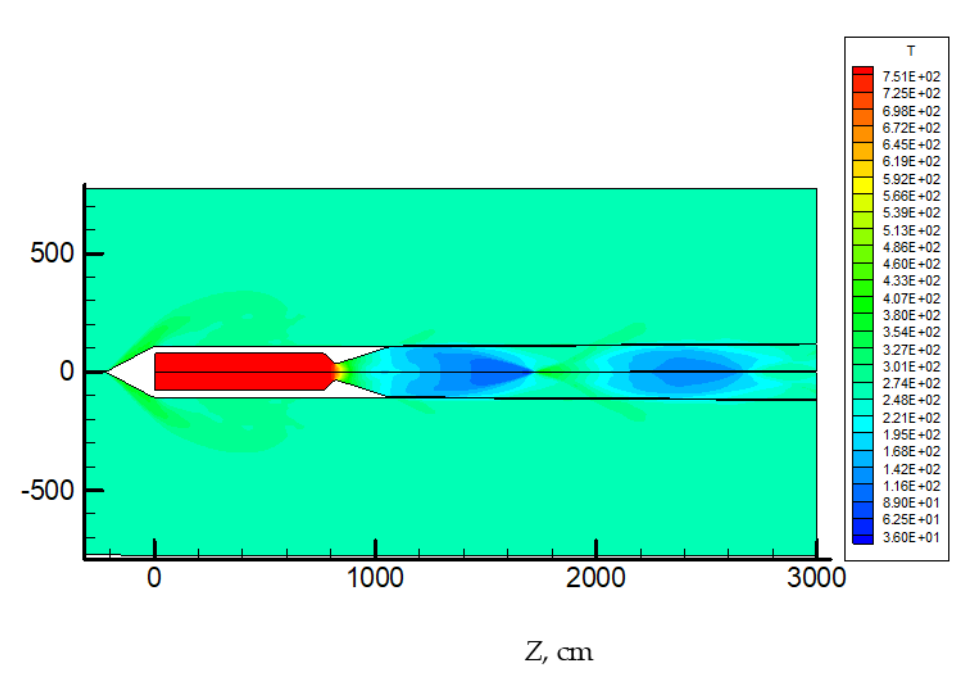
Figure 4. Spatial distribution of temperature T, K in the combustion products and the downpipe ( h = 25 km, n ≈ 1, M ∞ ≈ 2, and T ∞ = 270 K).